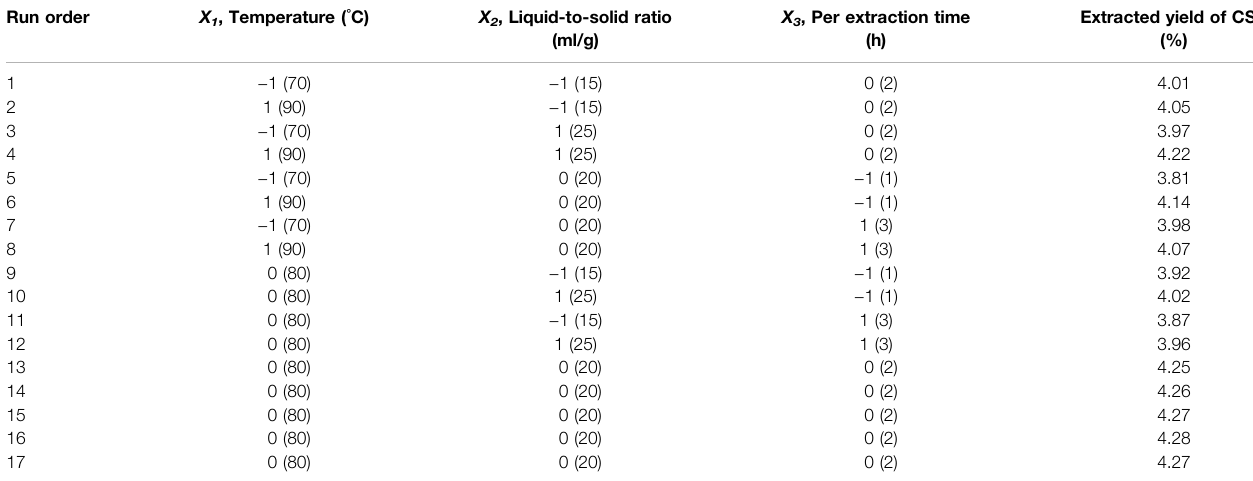
TABLE 1 | Box – Behnken design and results for extracted yield of CSP. Run